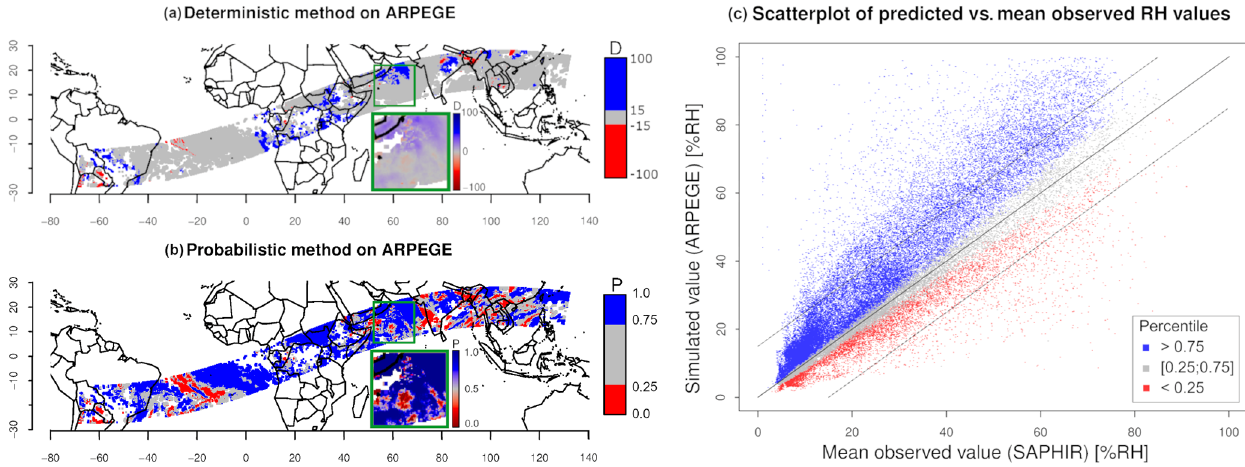
Figure 5. Comparisons between SAPHIR’s RH obs and ARPEGE’s RH mod on 1 April 2018 at 00:00UTC and for the 400–600hPa atmo- spheric layer. (a) Map of the difference D , (b) map of the probability P , and (c) scatterplot between RH obs ( x axis) and RH mod ( y axis); the percentile associated with each point is P > 0.75 (blue), 0.25 <P < 0.75 (gray) and P < 0.25 (red); the solid line represents the y = x line, and the dotted lines delimit the x ± 15%RH around